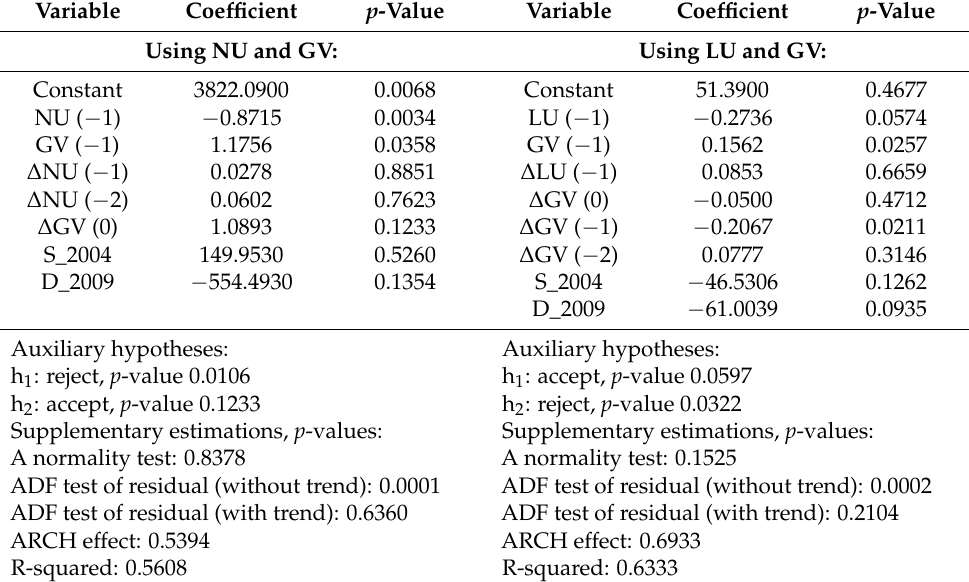
Table 6. Autoregressive distributed lag (ARDL) estimations for Latvia.